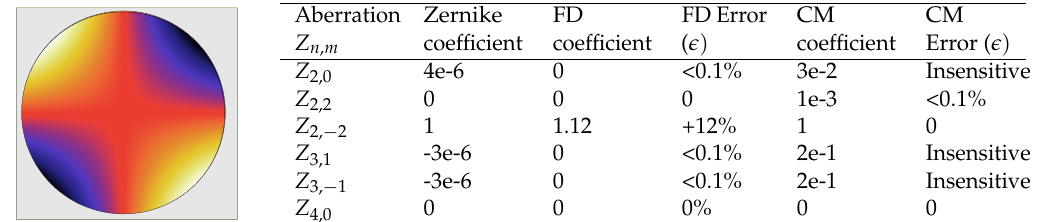
Figure 4. ( left ) Simulated wavefront map with strong astigmatism at 45 ˝ ; ( right ) table with corresponding Zernike coefficients of simulated test-wavefront map and obtained values using our Fourier demodulation (FD) script and the centroid method (CM). Units were arbitrary and normalized to simulated oblique astigmatism. Next to the Zernike coefficients of each method, the error is shown. In most cases, this error was insensitive or <0.1%.